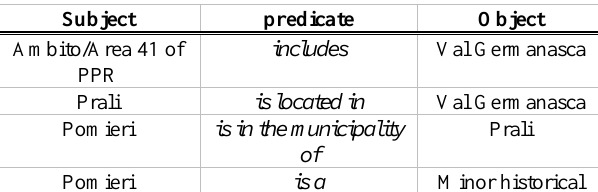
Figure 11. Concepts, relations and properties from the text of Società di Studi Valdesi (2012).